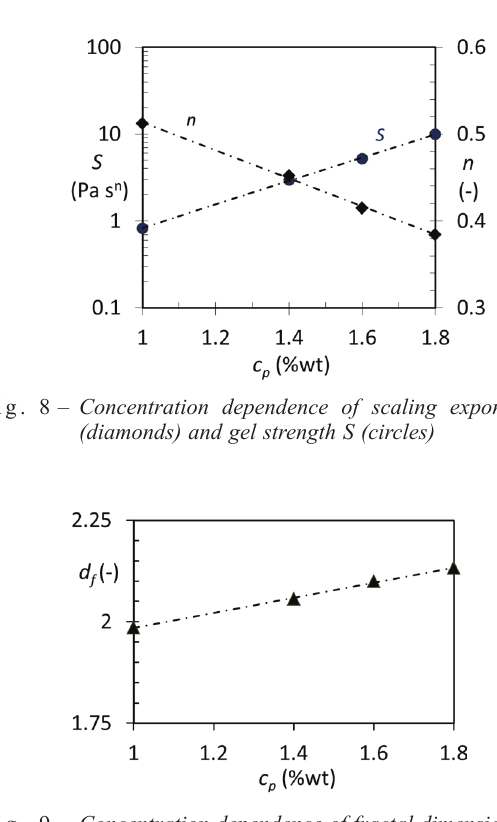
Fig. 9 – Concentration dependence of fractal dimension d